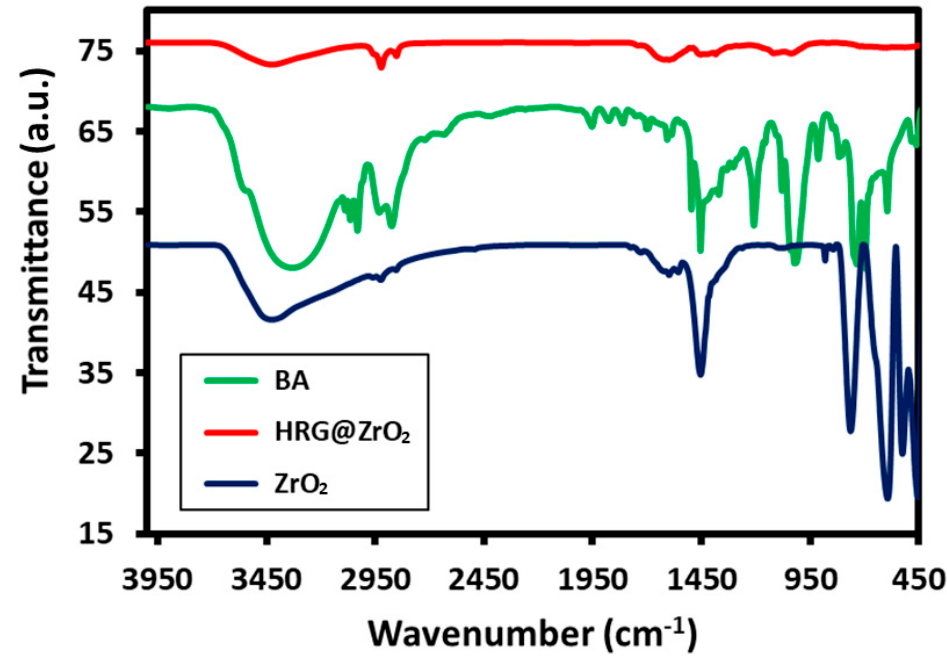
Figure 4. FT-IR spectra of ZrO 2 NPs (blue line), pure benzyl alcohol (BA, green line) and HRG@ZrO 2 (red line).